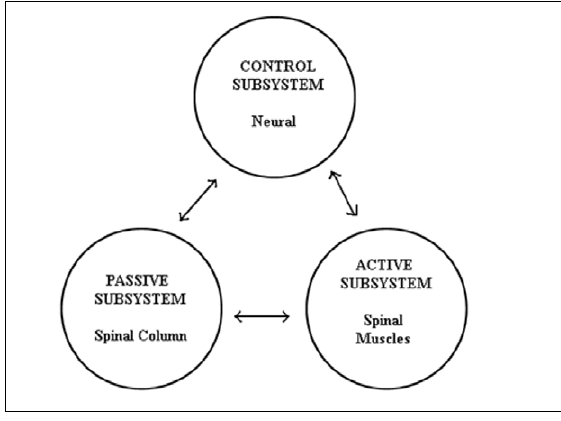
Figure 1. Spinal stability systems (Panjabi, 1992) Low back pain is the most expensive